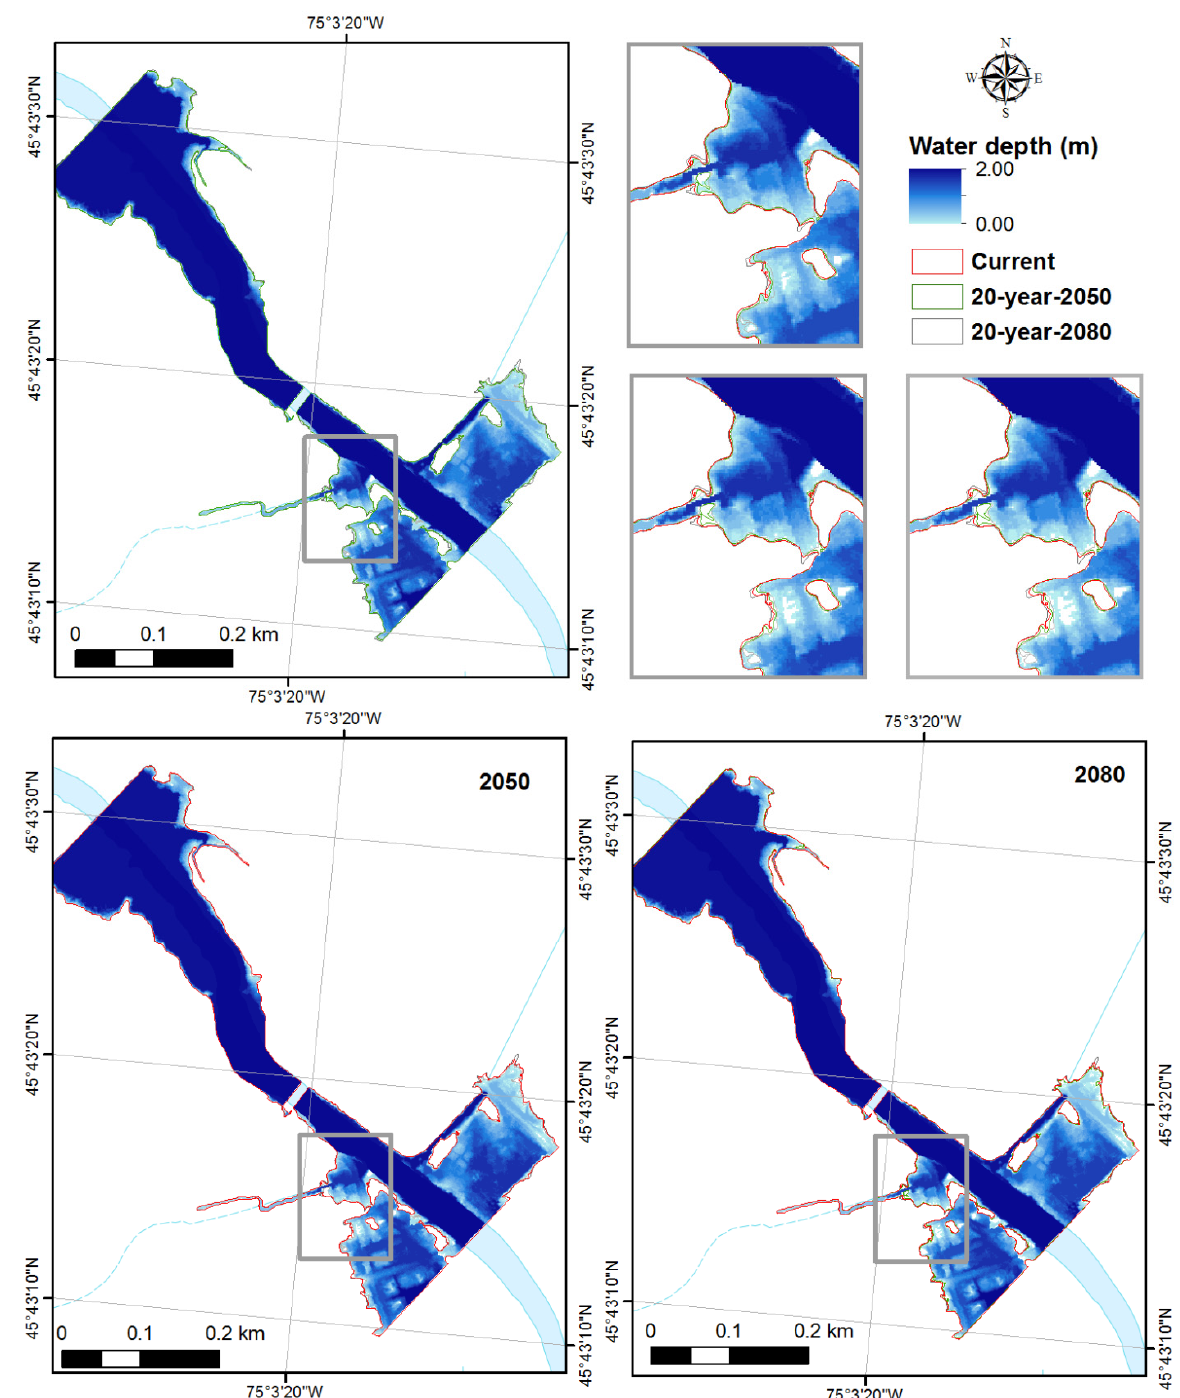
Figure A7. Projected flood depth for a 20-year return period (RCP 8.5). Case: St-Andre-Avellin.